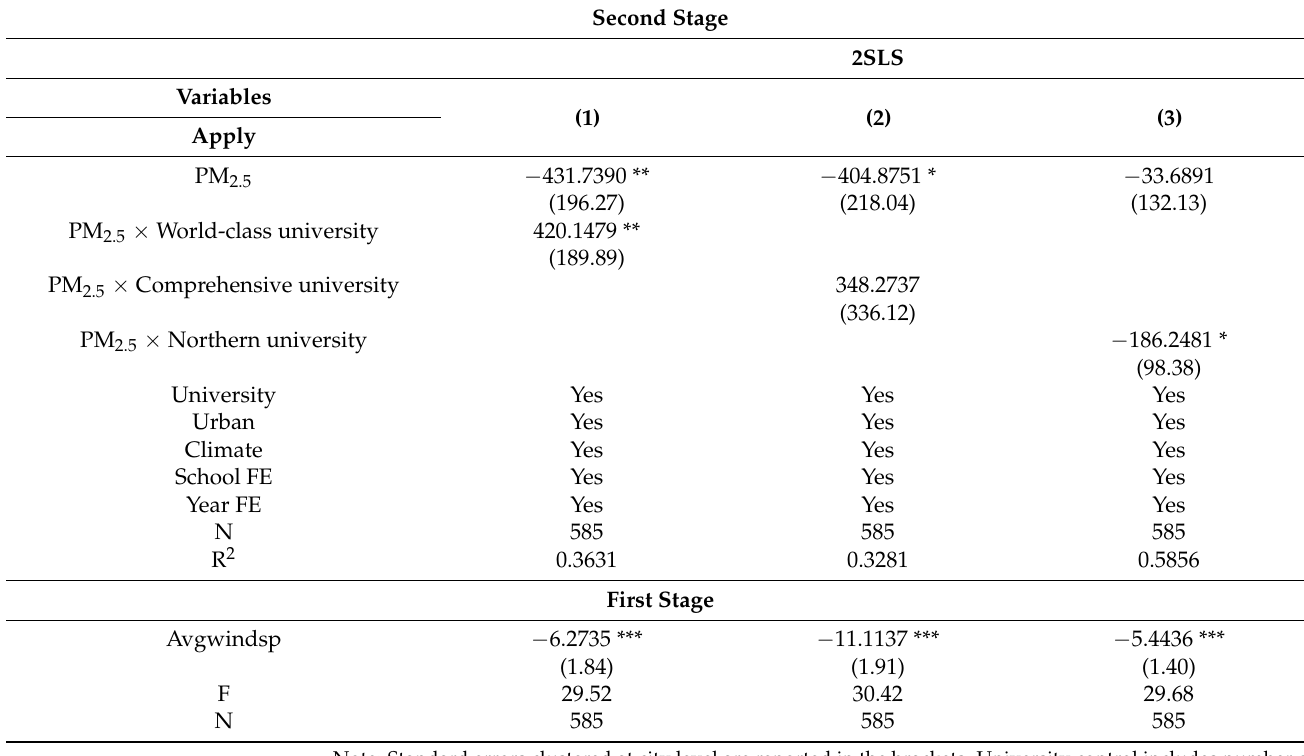
Table 6. The heterogeneous effects on migration